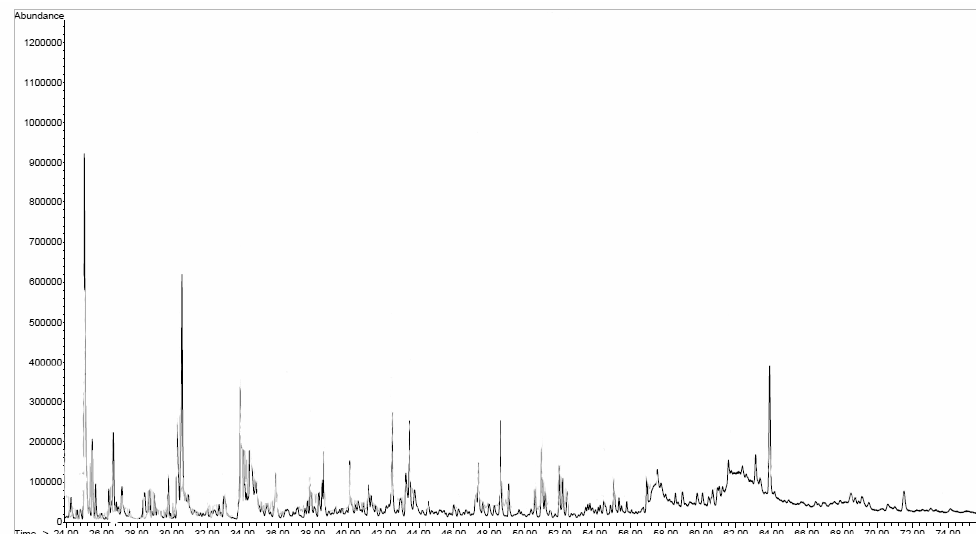
Figure 3. Gas chromatography–mass spectrometry (GC-MS) chromatogram of the effluent obtained from an SCWG process carried out at 560 °C, 250 bar, with an initial concentration of cellulose = 0.3 g/L and n = 0.4.